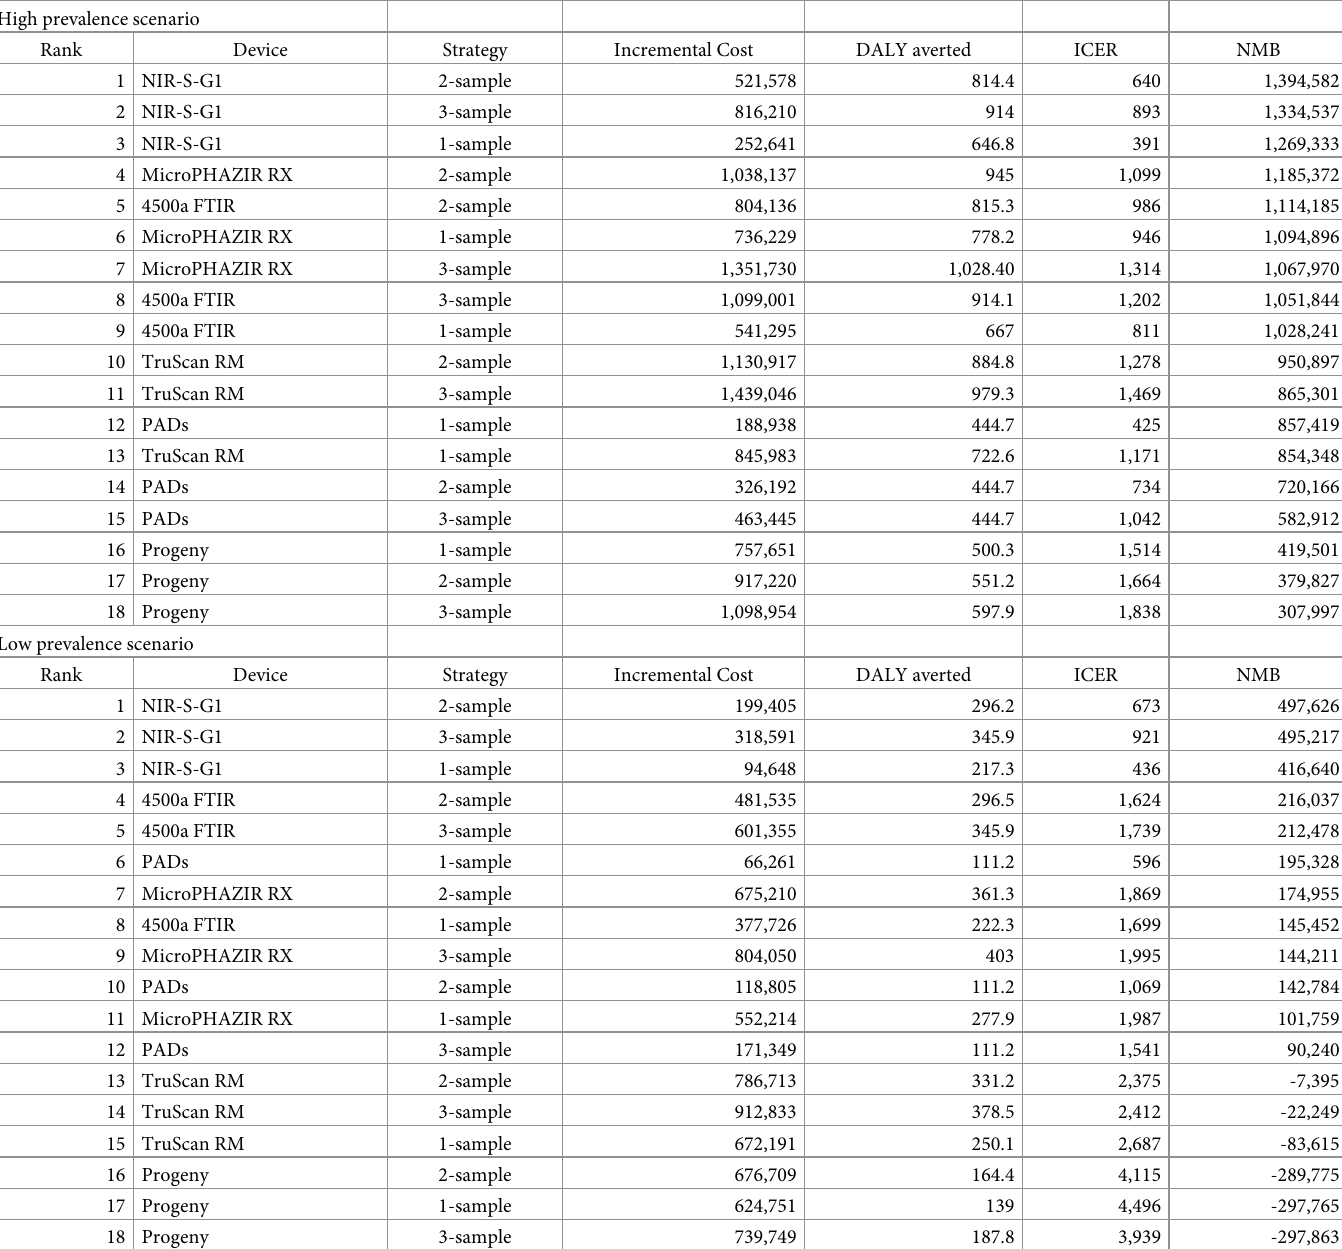
Table 6. Country level costs and effects in high and lower prevalence scenario per device and per different sample strategy compared with visual inspection ranked by descending net monetary benefits (NMB, US$). DALY—disability adjusted life year. ICER—incremental cost-effectiveness